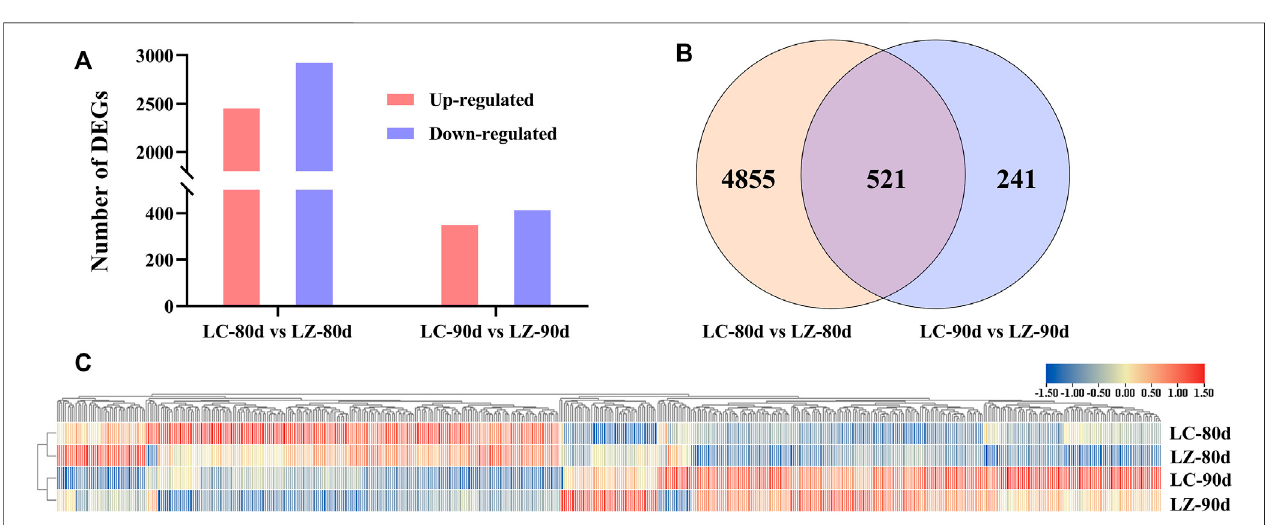
FIGURE2| DEGcomparison betweenLCand LZ. (A) Numbers ofupregulatedand downregulatedDEGsat 80 days after fl owering and 90 days after fl oweringof theearly-ripeningmutantLZ. (B) VenndiagramsofDEGsat80 daysafter fl oweringand90 daysafter fl oweringoftheearly-ripeningmutantLZ. (C) Theexpressionlevels of common DEGs between LC and LZ using the hierarchical clustering